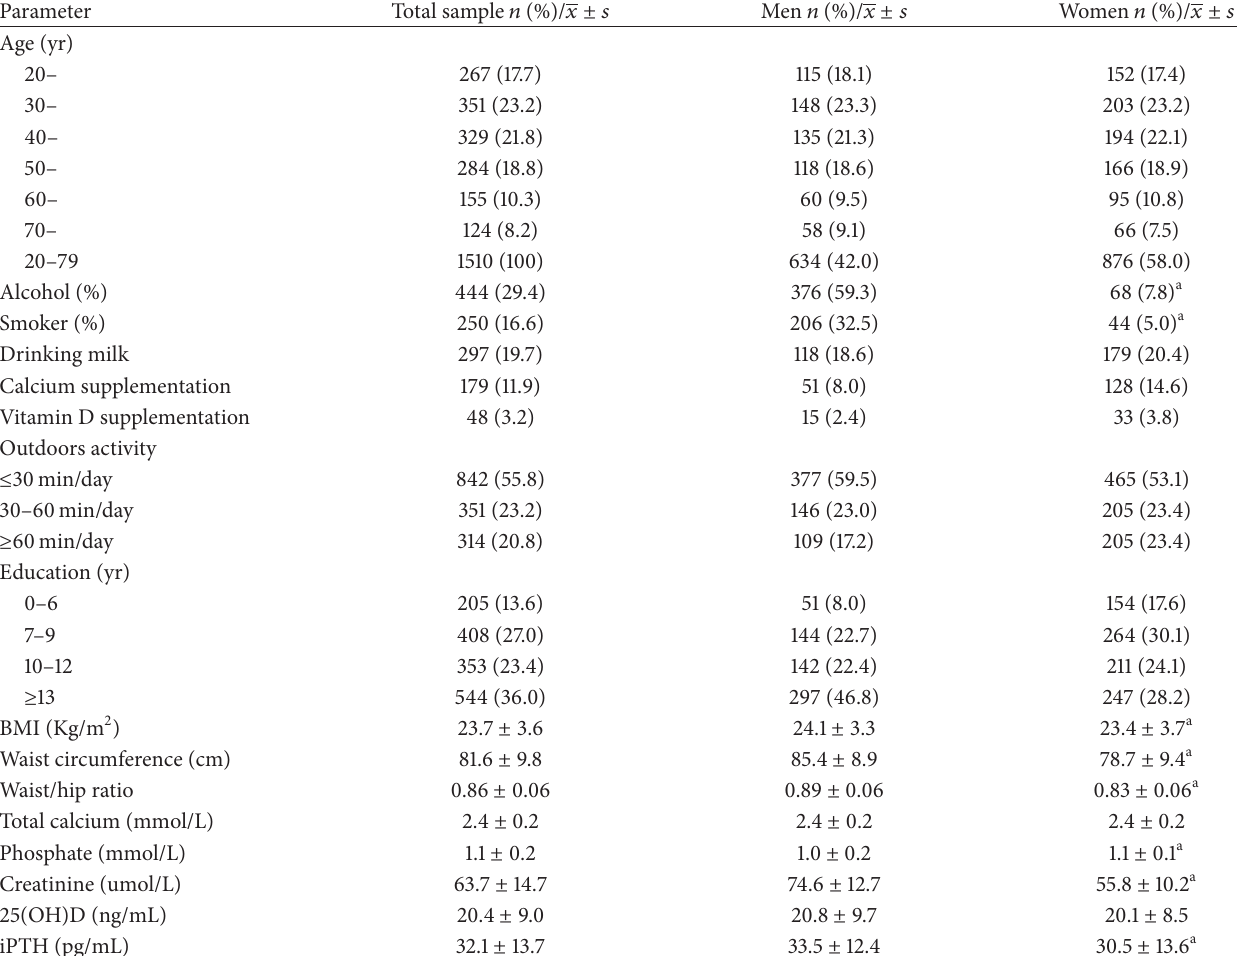
Table 1: Baseline characteristics ( 𝑛 = 1510 ).